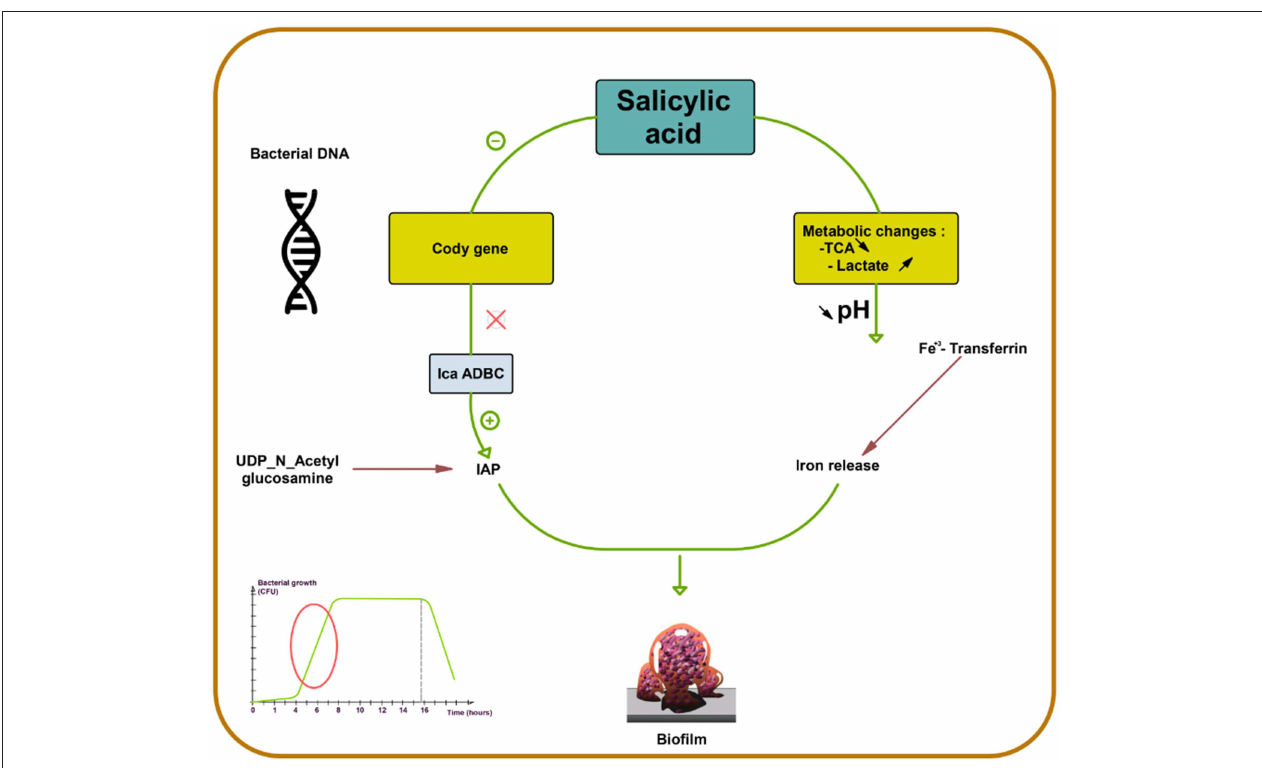
FIGURE 2 | Salicylic acid effect on biofilm formation in S. aureus . Salicylic acid (SAL) decreases the activity of tricarboxylic acid (TCA) and increases lactate production by potentiating the lactic fermentation pathway. This makes the medium acidic promoting iron release from human transferrin and its acquisition by S. aureus . In addition, SAL reduces the transcription of CodY, a global regulator that controls the expression of metabolism and virulence genes. CodY gene repression by SAL removes repression on icaADBC and thus enhances IAP production from UDP- N -acetyl glucosamine. SAL blocks negative control on icaADBC and results in increased biofilm formation ( 44,